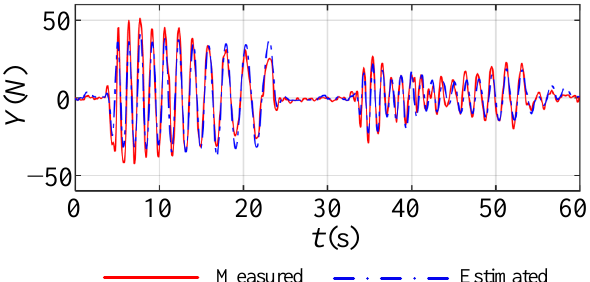
Figure 18. Comparison of the simulation results for the side force observation model with experi- mental data.